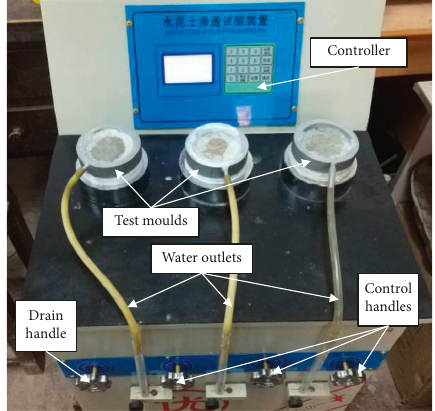
Figure 3: Cement soil permeability test